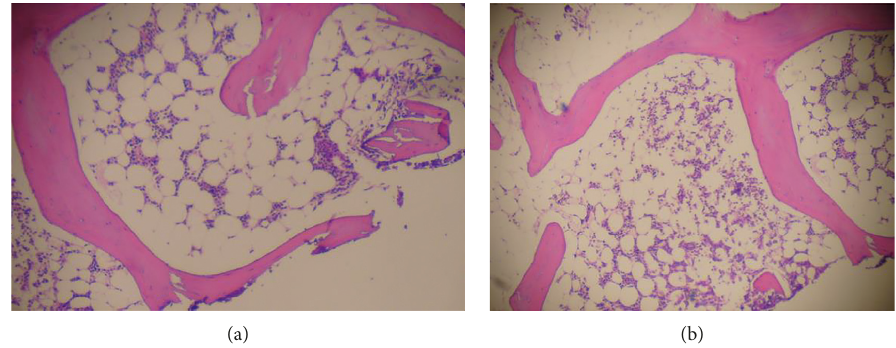
Figure 6: Repeated bone marrow biopsy showing marked decreased cellularity in comparison with the first